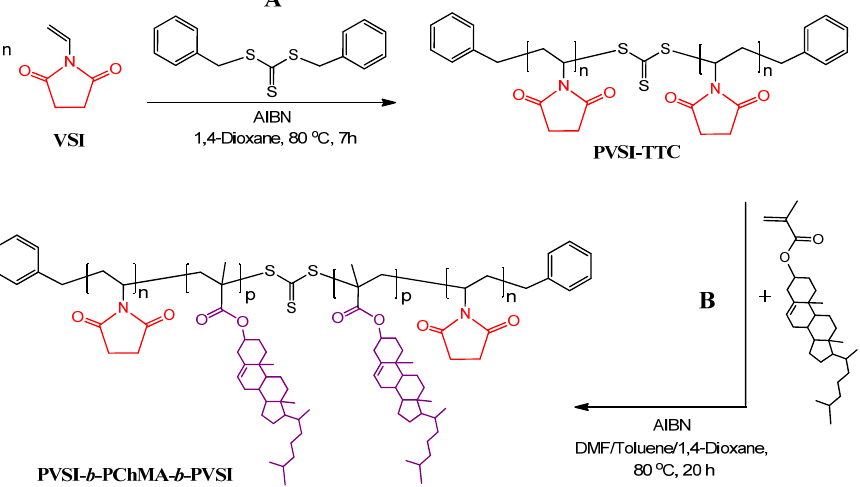
Figure 3. Schemes of synthesis of PVSI ( A ) and PVSI- b -PChMA- b -PVSI ( B